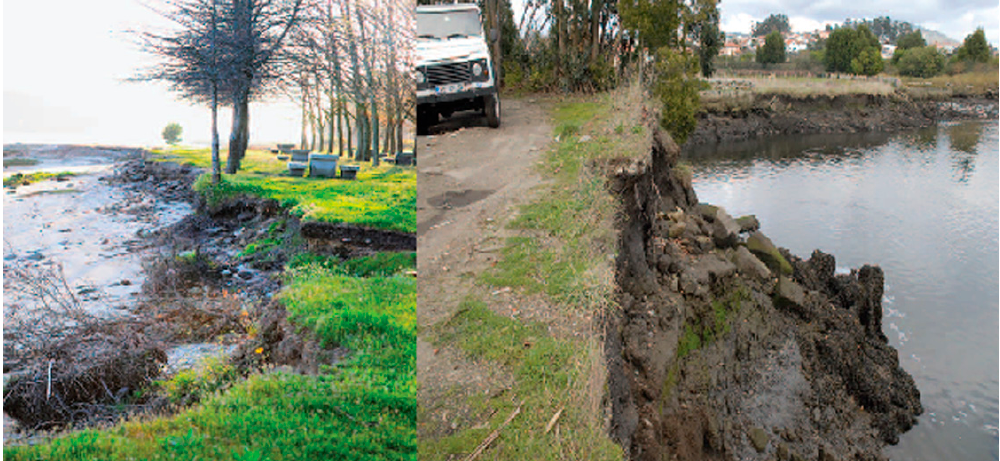
Figure 2 . Cardielos (left panel) and Portuzelo (right panel) sections in 2010, previous to the bank reinforcement, where an apparent bank collapse is visible. reinforcement, where an apparent bank collapse is